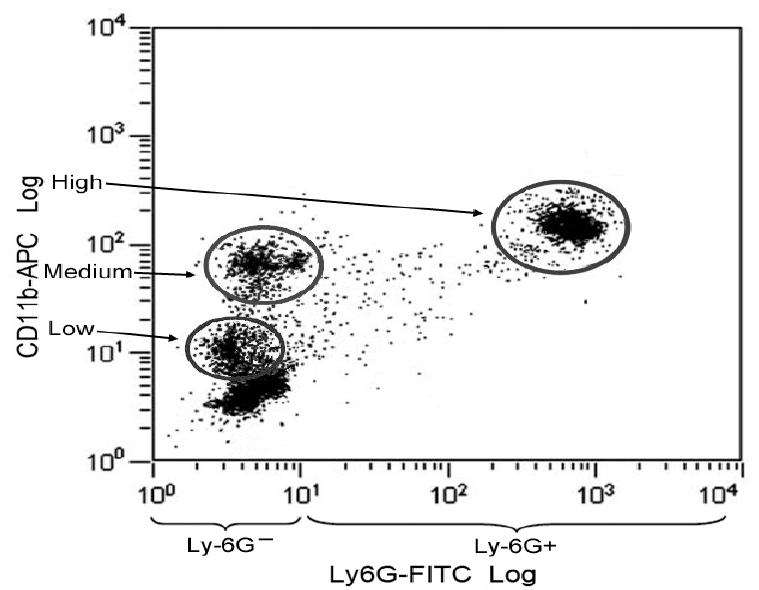
Figure 1. Monocytes identification from whole blood cells. NK cells: CD11b Low and Ly-6G − cells; Monocytes: CD11b Medium and Ly-6G − cells (Zhao et al., 2008). Neutrophils: CD11b High Ly-6G + cells (Comalada et al., 2003).